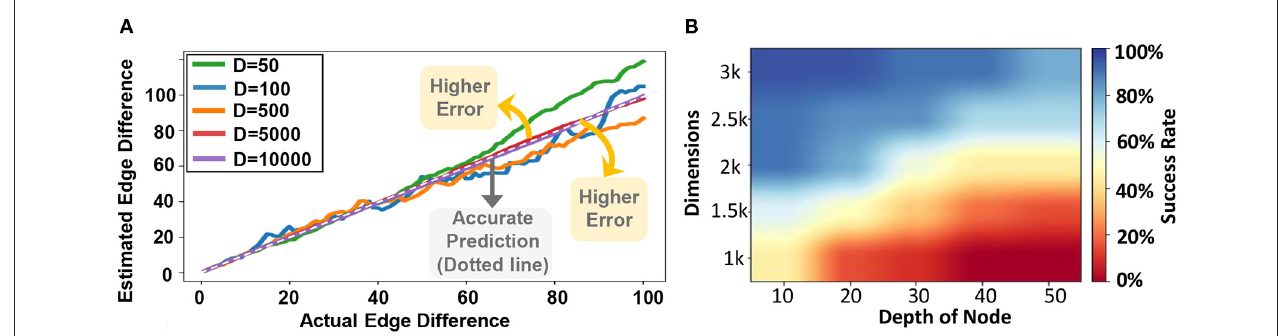
FIGURE 12 | (A) Graph matching vs. dimensions: actual vs. estimated edge difference (For a single model) and (B) GrapHD success rate performing shortest path on an encoded graph (shown over 1,000